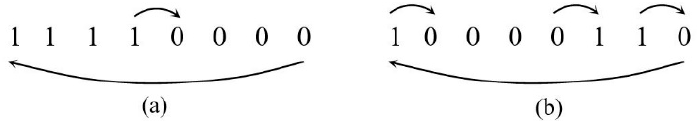
Figure 3. Uniform and non-uniform LBP code examples; ( a )uniform LBP; ( b ): non-uniform LBP